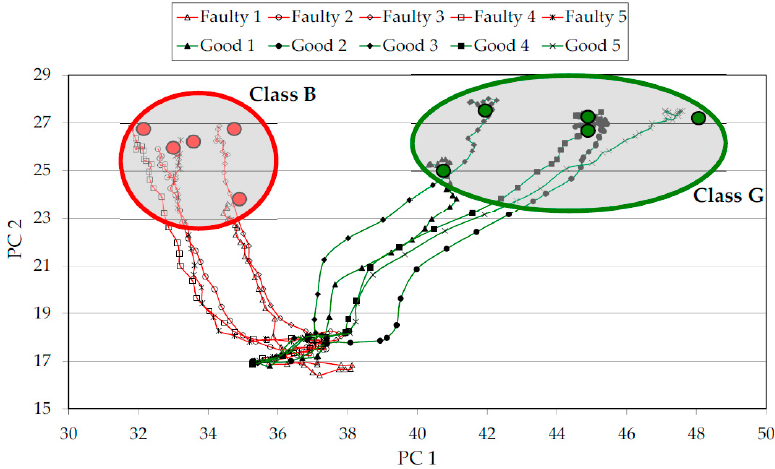
Figure 6. Time evolution of infrared images illustrated in 2D feature space composed of PC1 and PC2.